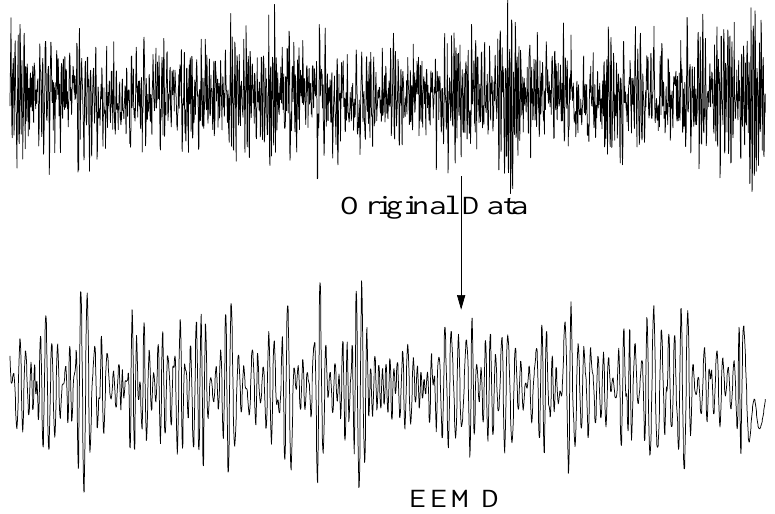
Figure 4. EEMD-processed original signal. Considering the actual situation of bearing degradation, in this paper, we suggest that the bearing degradation should not be simply set as a (0-1) straight line, but rather should be designed as three stages. Therefore, after extracting 11 frequency domain indicators of the bearing, PCA was used to fuse the 11 frequency domain features [23]. The 11 frequency domain indicators are shown in Table 2. Among them, there are two defined frequency domain indicators, which are the fifth center frequency and the tenth root mean square frequency, and the remaining 9 indicators are commonly used in the frequency domain. The basic principle of PCA is to transform the original variables with a certain correlation into a set of unrelated data through linear transformation, and its main formula was as follows: